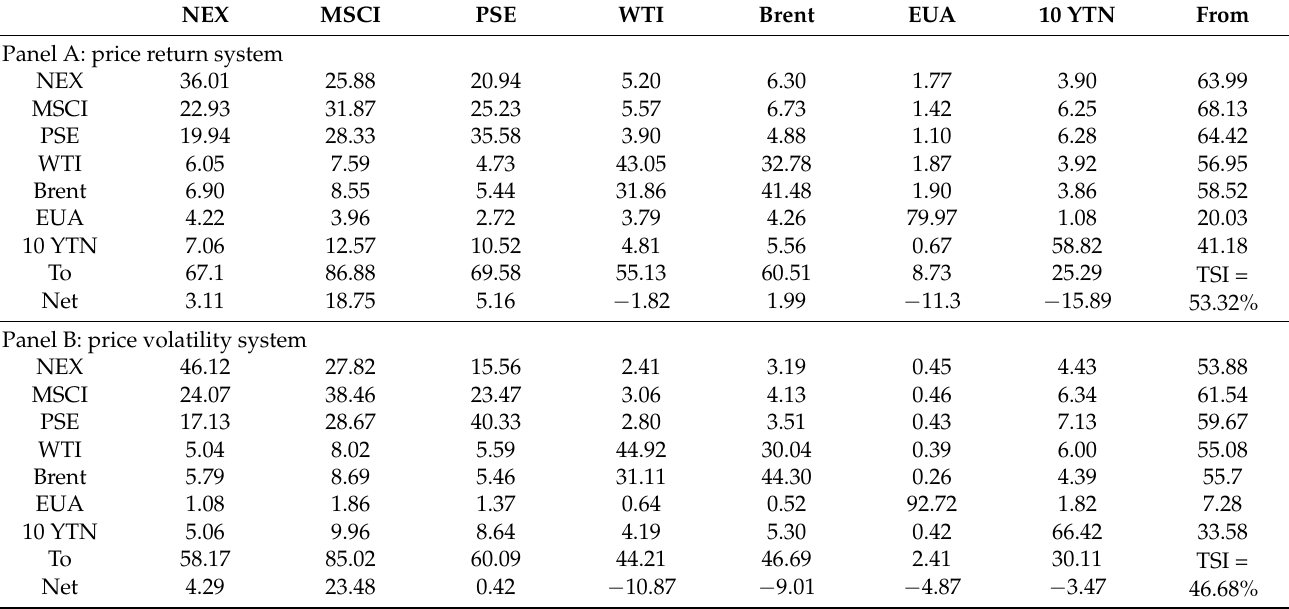
Table 2. Static connectedness matrix over the full sample